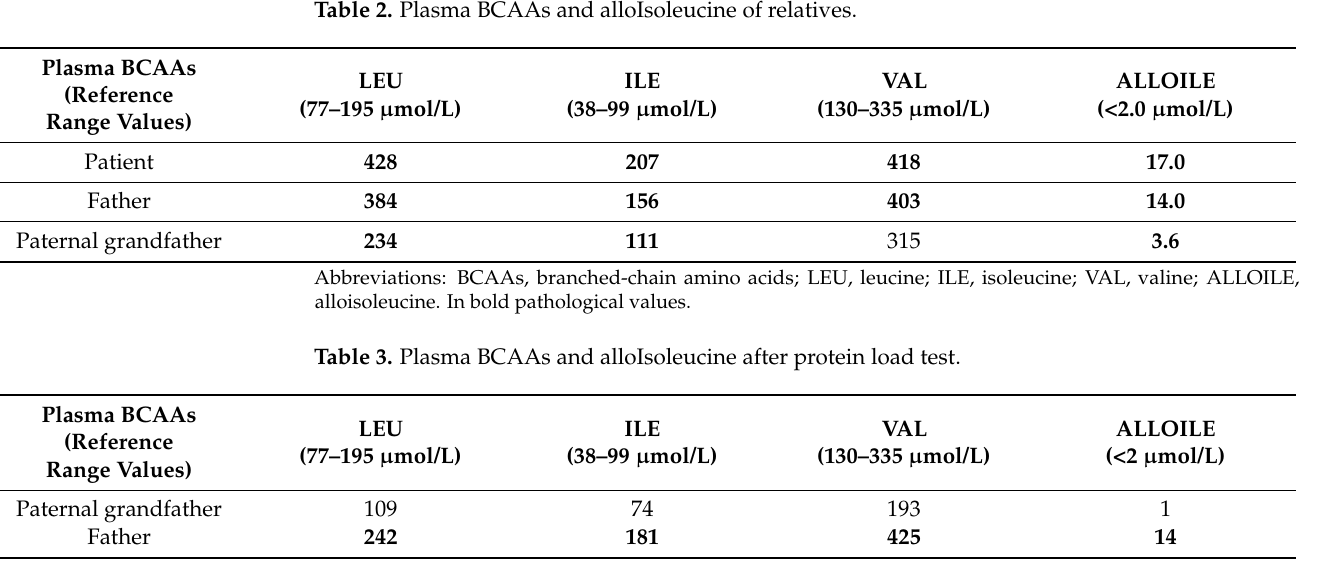
Table 2. Plasma BCAAs and alloIsoleucine of relatives.